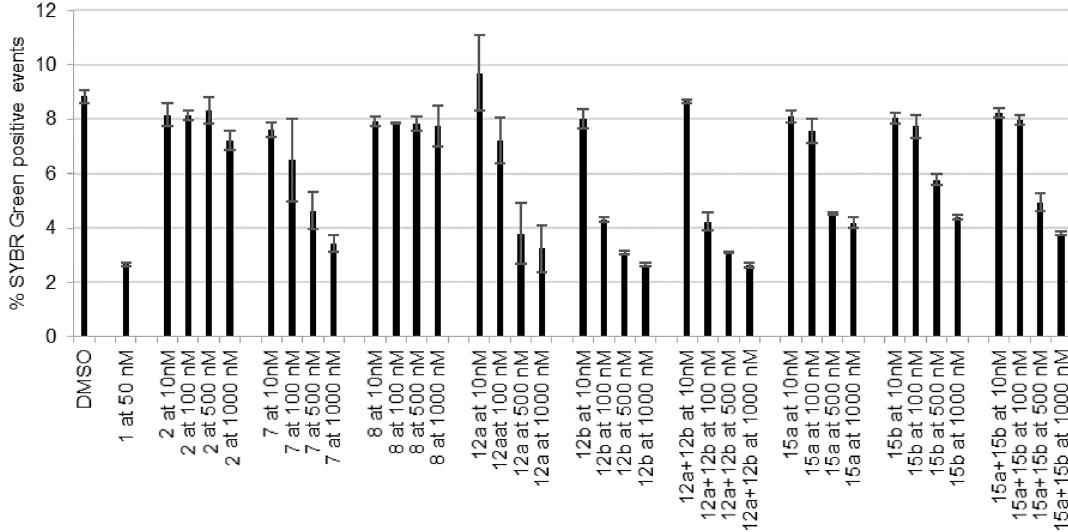
Figure 11. Assessment of in vitro activity of compounds against the blood stage of P. falciparum infection. Percentage of SYBR Green positive events (parasitemia) against each compound at 1000 nM, 500 nM, 100 nM, and 10 nM is shown. Chloroquine (CQ) at 50 nM was used as the positive control. Results were compared with the negative control (DMSO) and are represented as the mean ± SD of technical triplicates, n = 1.